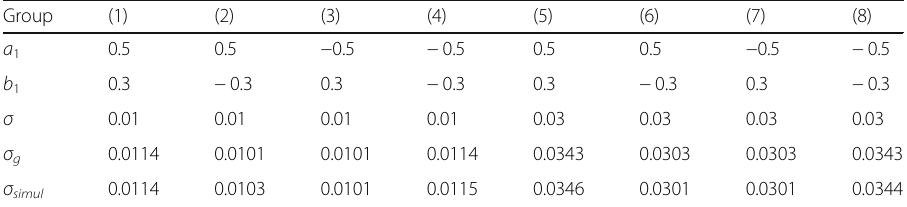
Table 2 Results on risk for the ARMA (1,1) process. The table reports the actual standard deviations of the simulated returns and their theoretical values for nine ARMA (1,1) processes with different parameters. The actual standard deviation of the simulated returns is denoted by σ simul , and its theoretical value is denoted by σ g